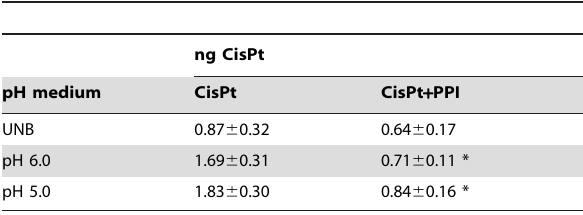
Table 2. Content of CisPt in the exosomes from + / 2 PPI pre-